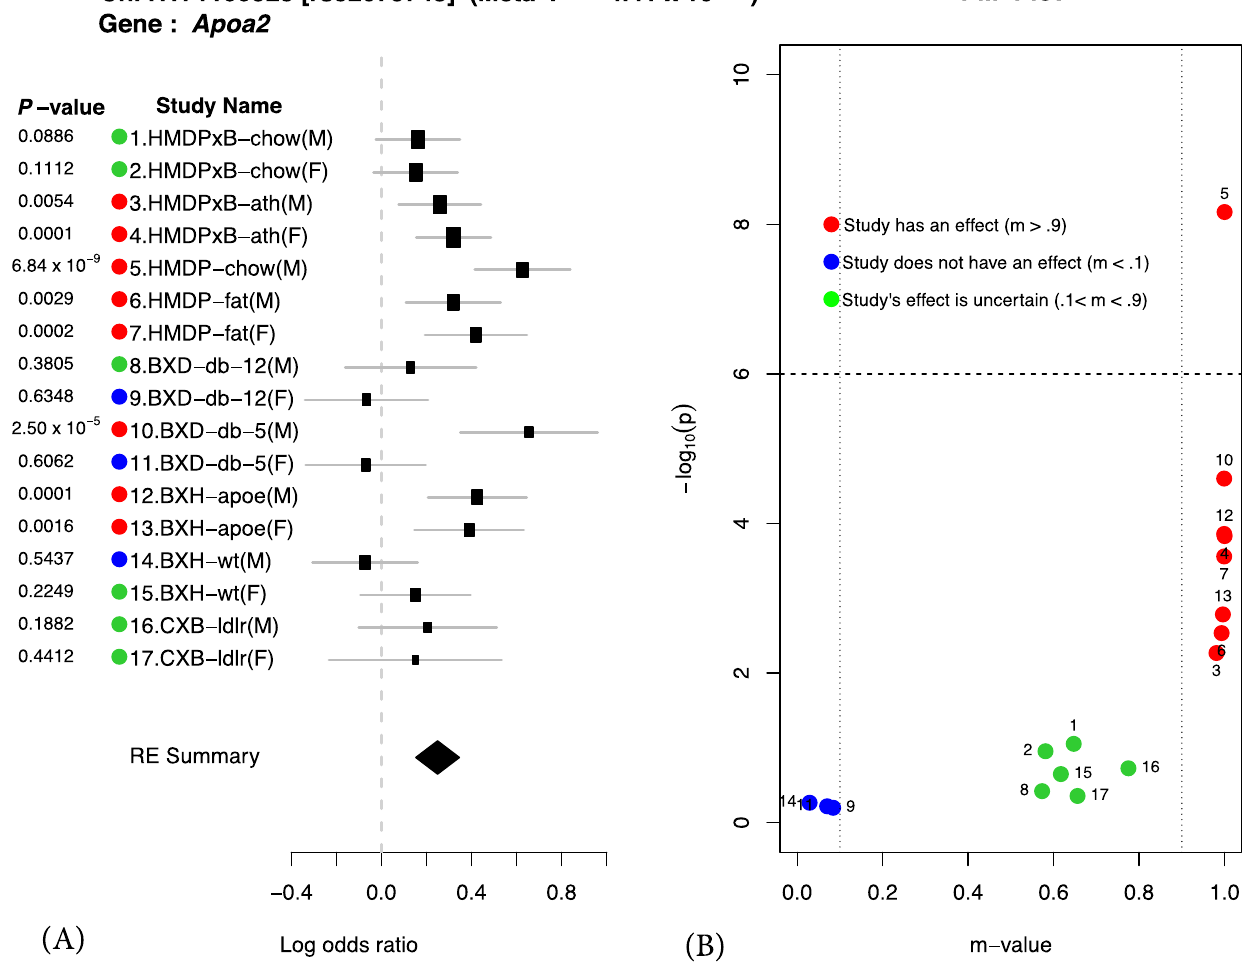
Figure 1. Application of Meta-GxE to Apoa2 locus. The forest plot (A) shows heterogeneity in the effect sizes across different studies. The PM- plot (B) predicts that 7 studies have an effect at this locus, even though only 1 study (HMDP-chow(M)) is genome-wide significant with P -value.